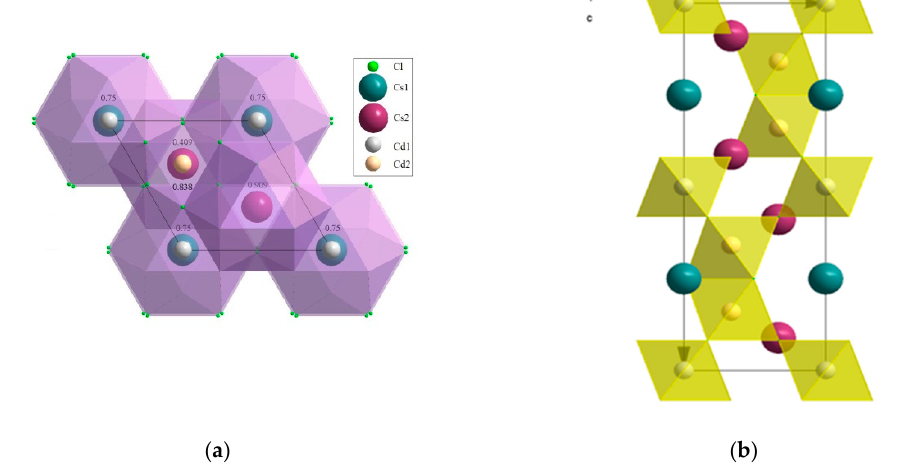
Figure 14. Crystal structure of CsCdCl 3 : ( a ) the xy projection with polyhedra for the Cs atoms; ( b ) the xz projection with polyhedra for the Cd atoms.